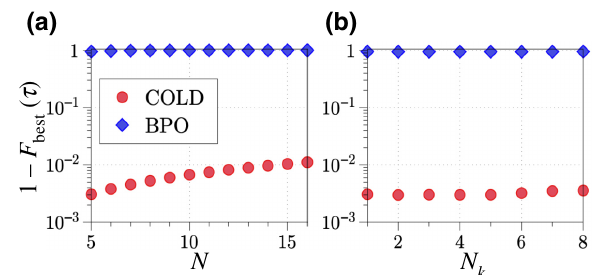
FIG. 4. Scaling of fidelities (plots show 1 − F ) in the anneal- ing protocol for the Ising model with (a) system size N and (b) optimization parameters N k at driving time τ = 10 − 2 J − 1 . Plots show a comparison between BPO (blue diamonds) and COLD (red circles). In (a) we see that the COLD fidelity decreases as a function of N but remains quite high when compared to BPO, while (b) shows the nonexistent improvement for both BPO and COLD with an increasing number of parameters in the N = 5 spin case. Once again, plotted best fidelities are obtained across 500